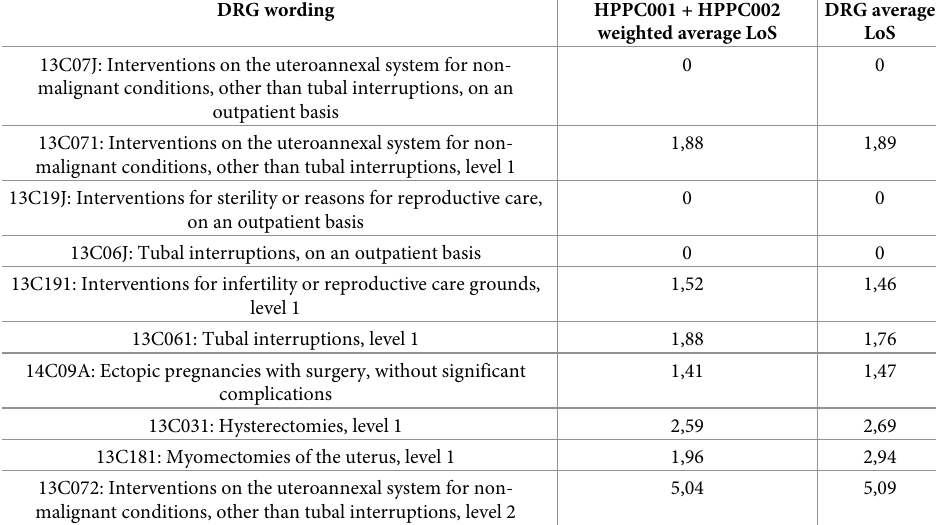
Table 3. Main DRG according to HPPC001 and HPPC002 medical